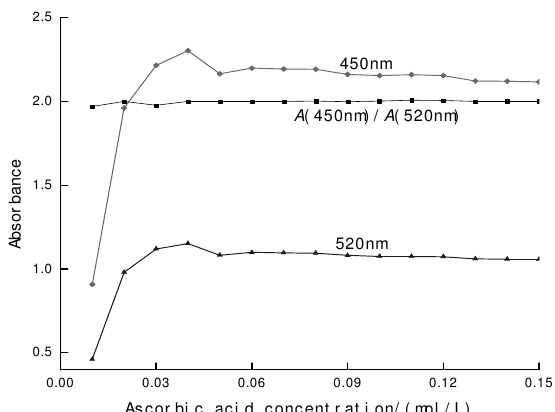
Figure 3. Plots of Vc concentration vs. absorbance of product